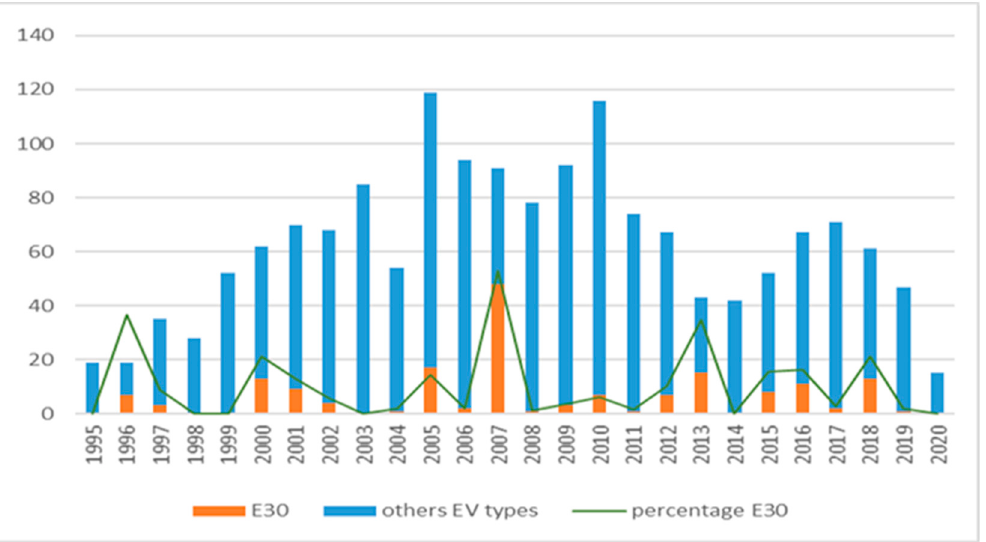
Figure 1. Annual distribution of E30 detections vs. other EV genotypes. Table 3. E30 infections with respect to the total of EV genotyped by year.